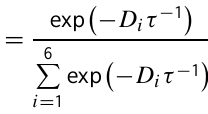
Fig. 3. Total river runoff applied in MOMBA in units Sv ( =10 6 m 3 s − 1 ). Figure 3. Total river runoff applied in MOMBA in units of Sverdrup (Sv) (=10 6 m 3 s − 1